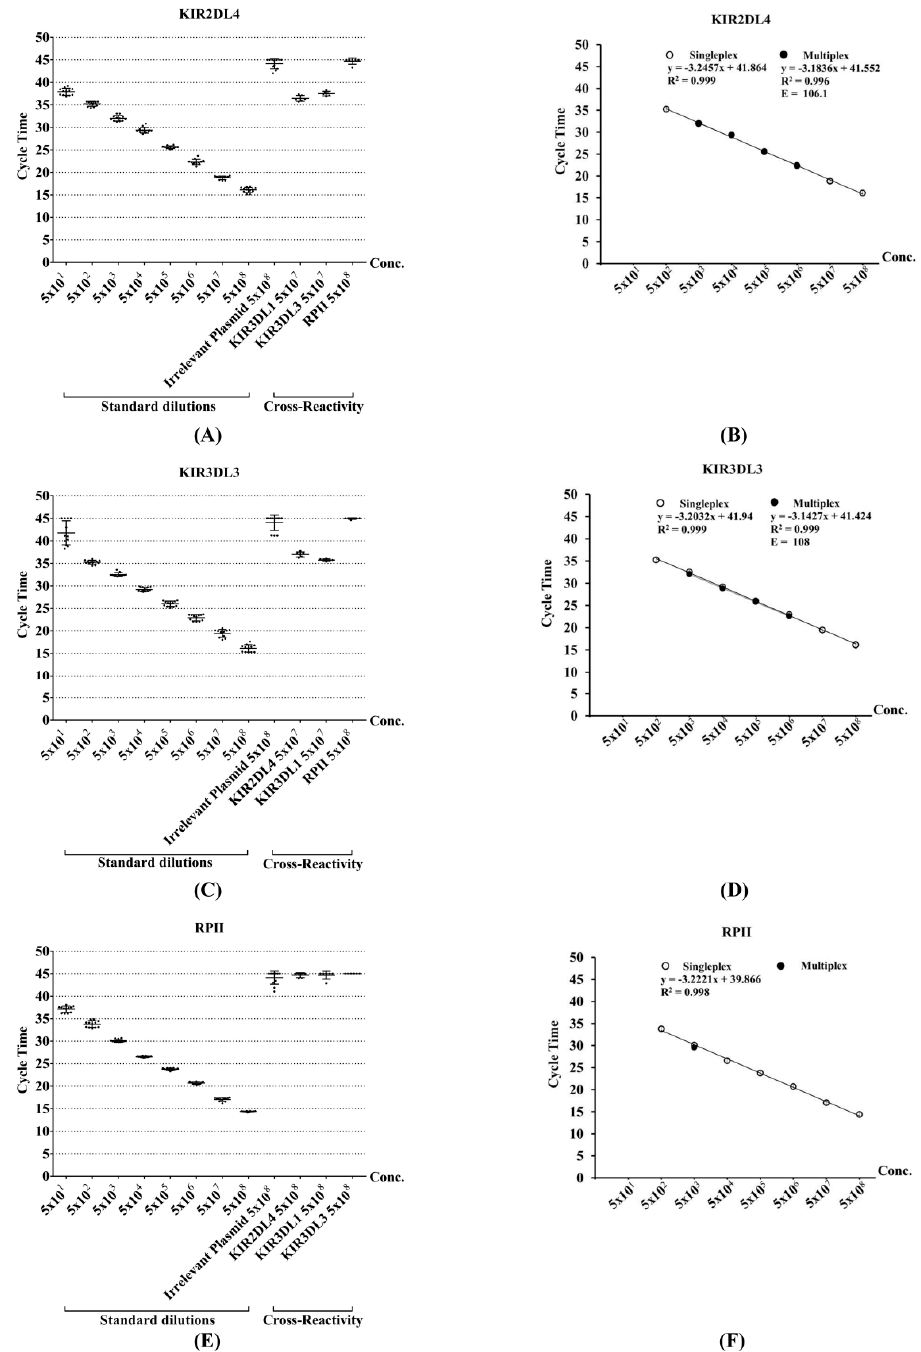
Figure 1. Characterization of the quantitative real-time reverse transcription polymerase chain reaction (qRT-PCR) with fluorescent probe assays to detect KIR2DL4 , KIR3DL3 and RPII . Left panel shows the scatterplot of the mean cycle time ( C t ) for each concentration of the targets, an irrelevant sequence plasmid, RPII and non-target KIR plasmids to evaluate the sensitivity, specificity and reproducibility of primers/probes for ( A ) KIR2DL4 ( C ) KIR3DL3 and ( E ) RPII detections; The right panel shows the plot of C t against the log of the copy number standards. The multiplex reactions showed comparable efficiencies as the singleplex reactions for ( B ) KIR2DL4 ( D ) KIR3DL3 and ( F ) RPII . The standard curves are shown with the equation of linear regression, a square regression coefficient ( R 2 ) and the efficiency (E) for qRT-PCR.